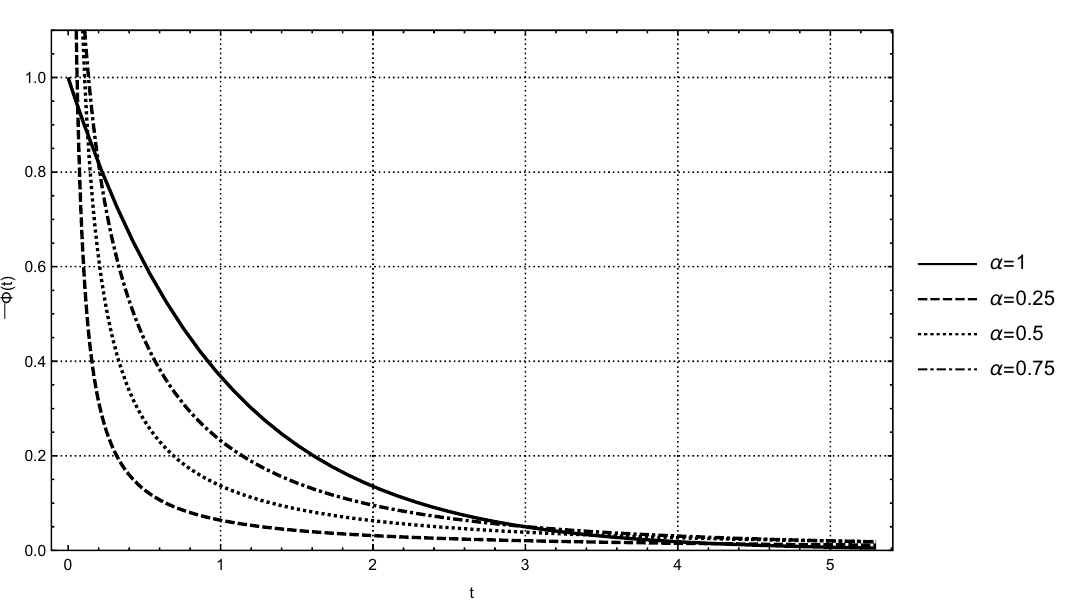
Figure 2. Plots of the positive function − Φ α ( t ) for α = 0.25,0.50,0.75,1 versus t ∈ [ 0,5 ]